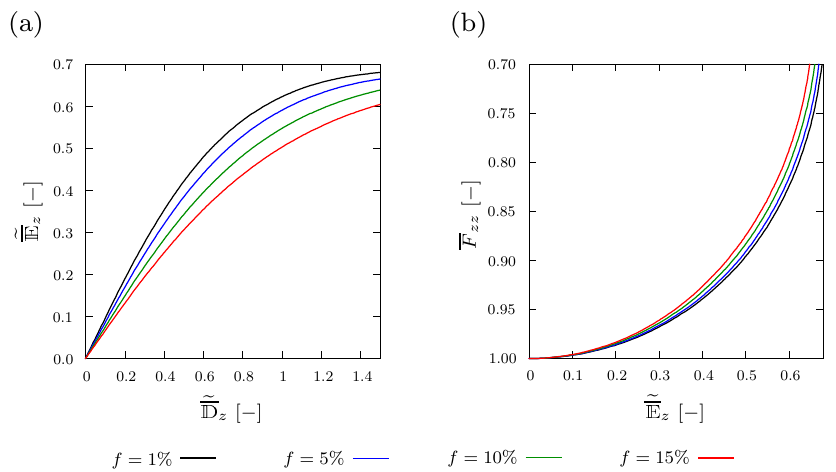
Figure 8. Plot of ( a ) averaged and normalized electric displacement (cid:101) D z [ − ] and ( b ) averaged defor- mation F zz [ − ] versus averaged and normalized electric field (cid:101) E z [ − ] with different volume fractions f of a spherical inclusion with θ init = 298 Kelvin.